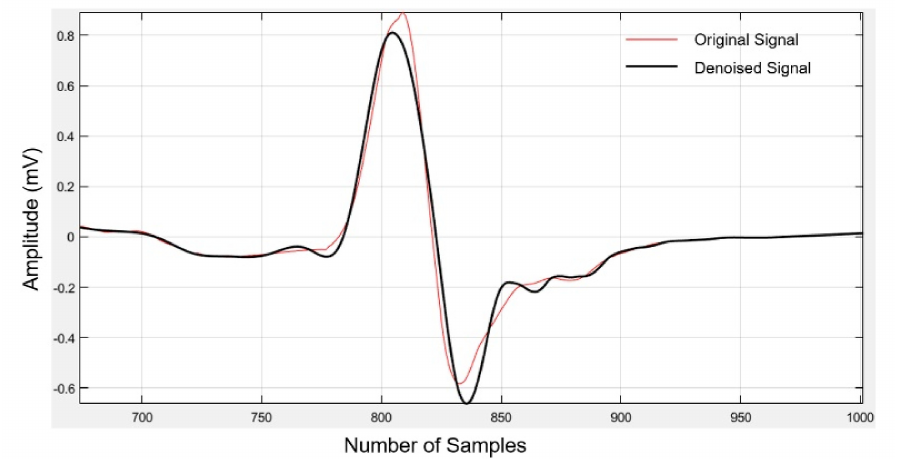
Figure 1. Original and denoised electrocardiogram (ECG) signal using Daubechies wavelet